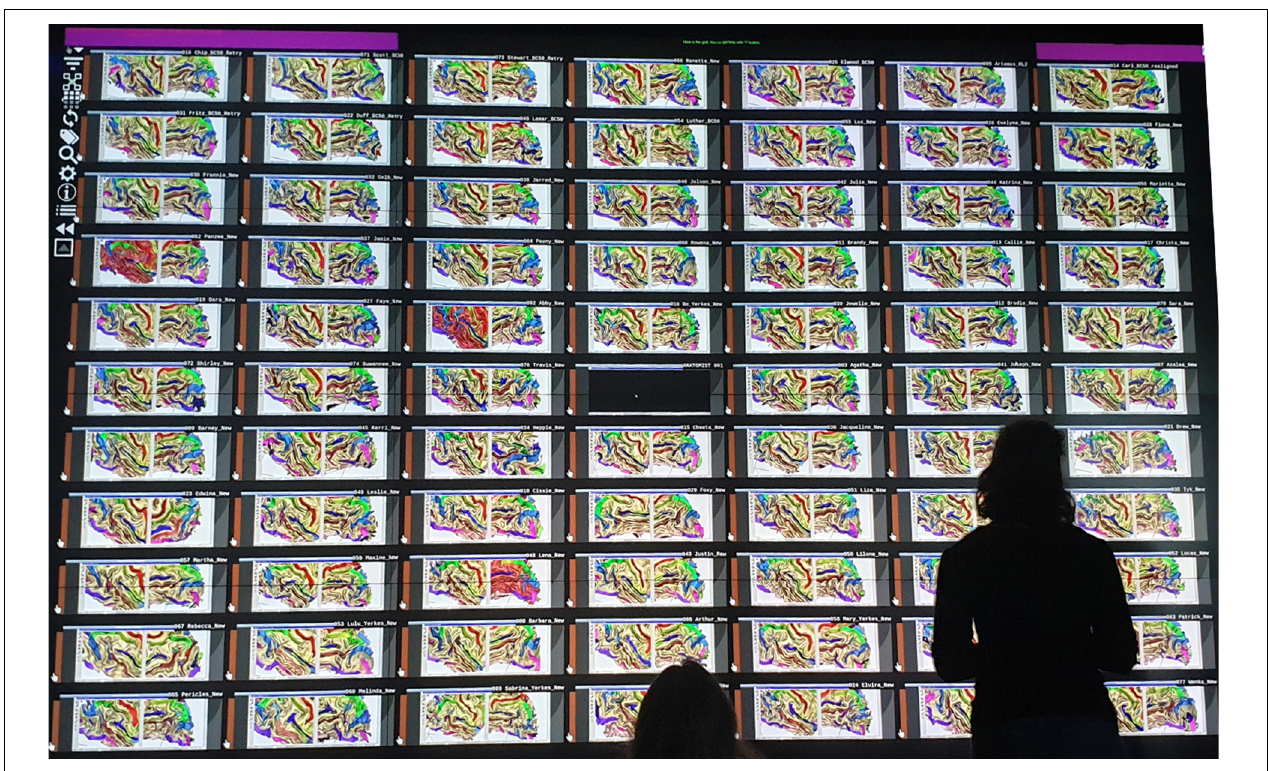
FIGURE 7 | A fold labeling session in front of a wall-size screen to design a chimp-based structural atlas of cortical